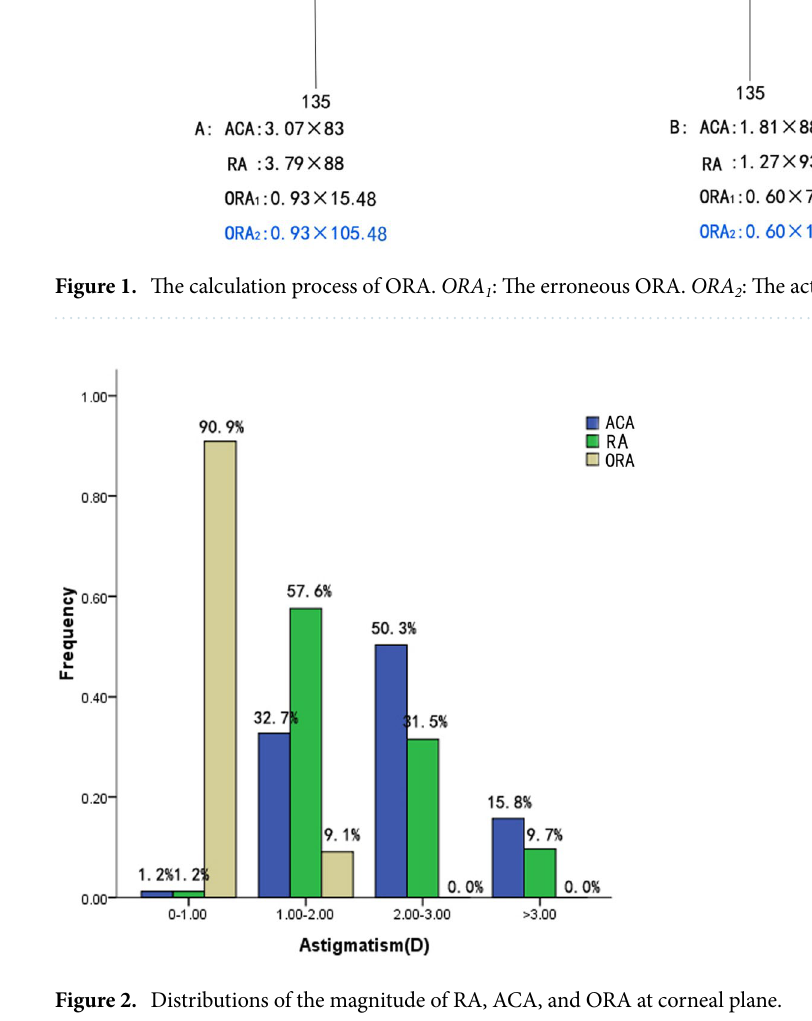
Figure 2. Distributions of the magnitude of RA, ACA, and ORA at corneal